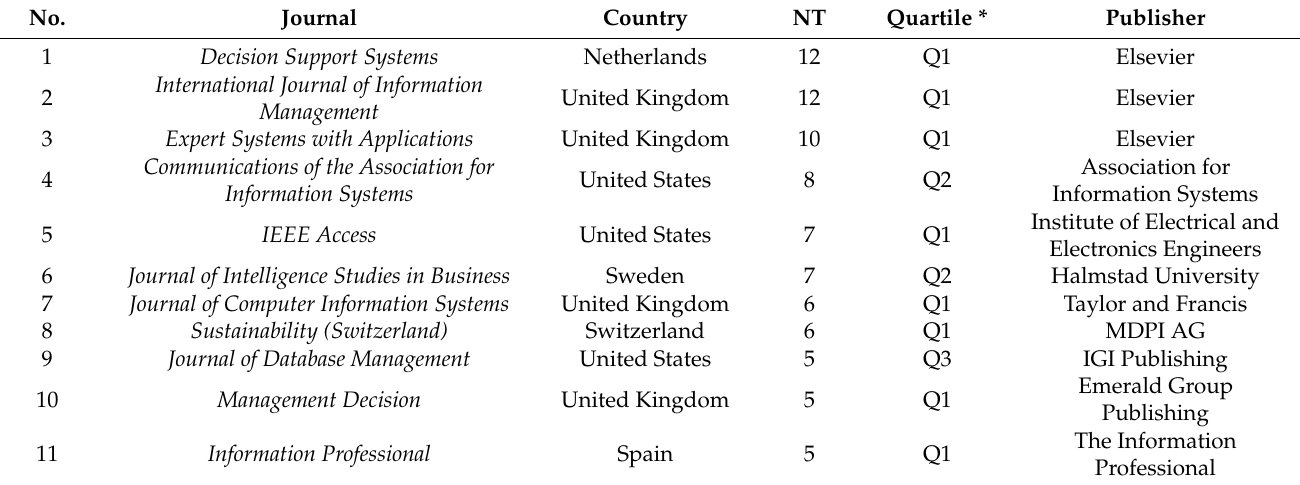
Table 6. Most productive journals by country, number of documents, quartile and publisher.